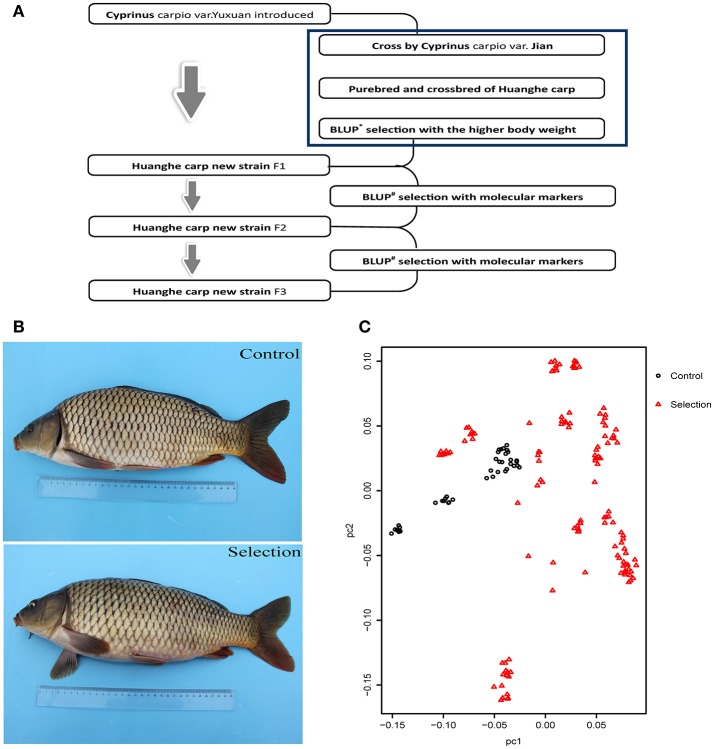
Generation and growth of the new Huanghe carp strain (Xinlong). (A)
Xinlong strain selection progress overview. (B) Traditional Huanghe carp strain (Control) and the new Xinlong strain (Selection). (C) Principal Component analysis: the first dimension PC1 was assigned to X axis and the second dimension PC2 was assigned to Y axis. Red triangles represent the selection group, black circles the control group.